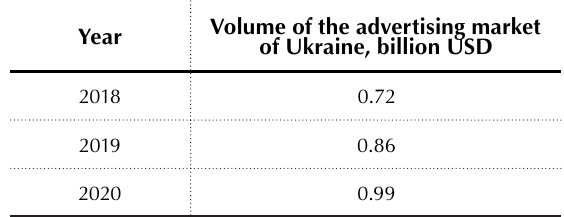
Table 6. The perspective dynamics of change of volume of the advertizing market of Ukraine during the period 2018−2020, billion USD Source: Own